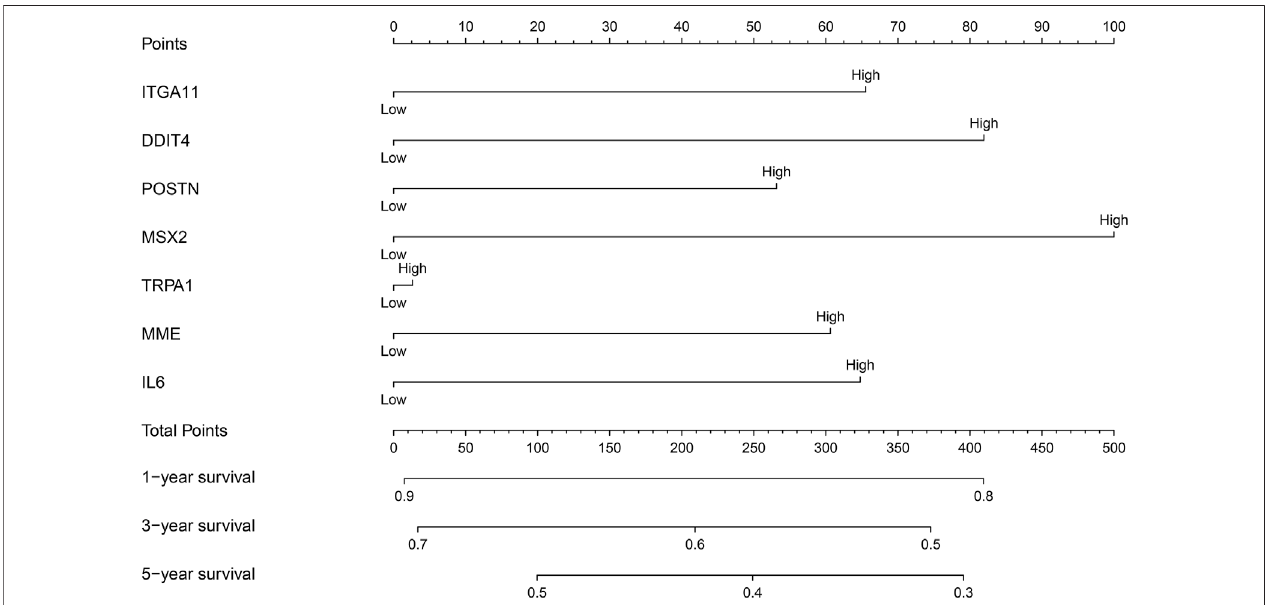
FIGURE 4 | Nomogram of prognostic DEGs of MSCs. MSCs, Mesenchymal stem cells; DEGs, differentially expressed genes.